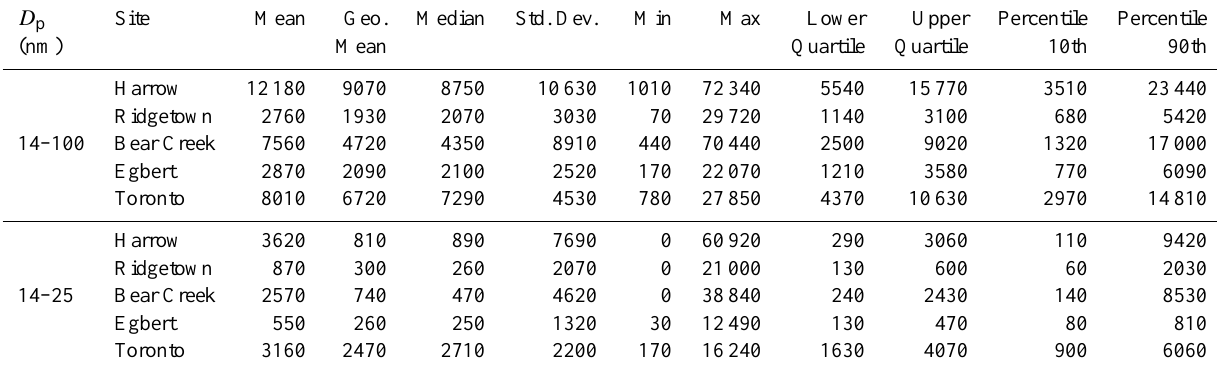
Table 2. Descriptive statistics for number concentrations (#cm − 3 ) of particles in the size ranges 14nm to 100nm and 14nm to 25nm at the five sites during the BAQS-Met campaign (20 June–8 July 2007).